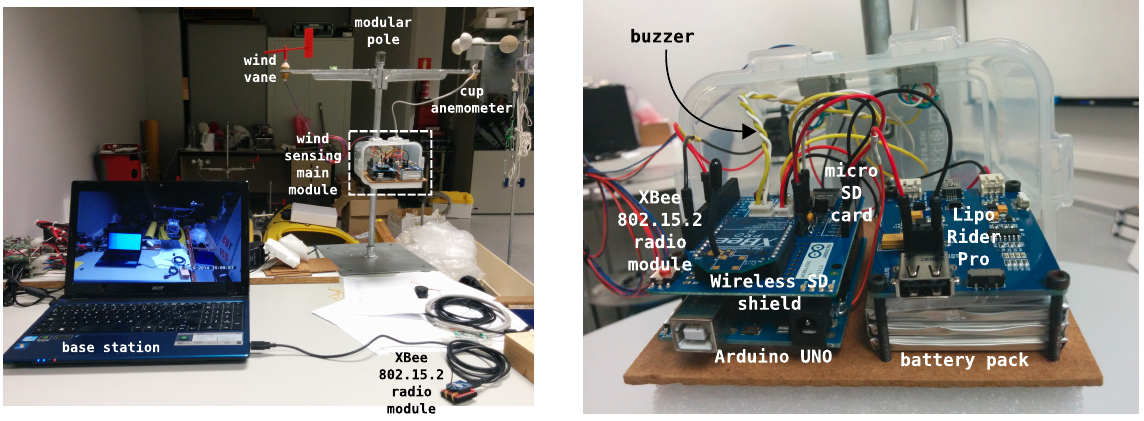
Figure 3. Base station and wind sensing